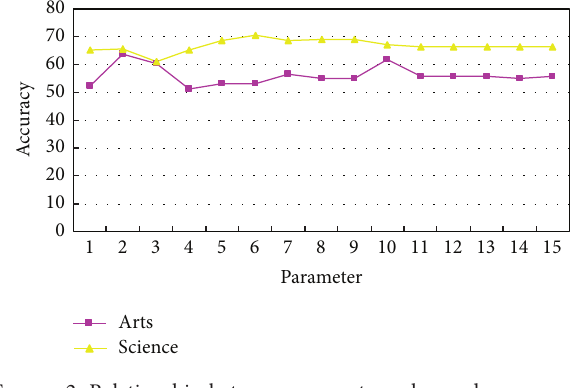
Figure 2: Relationship between parameter value and accuracy of Hebei Province.